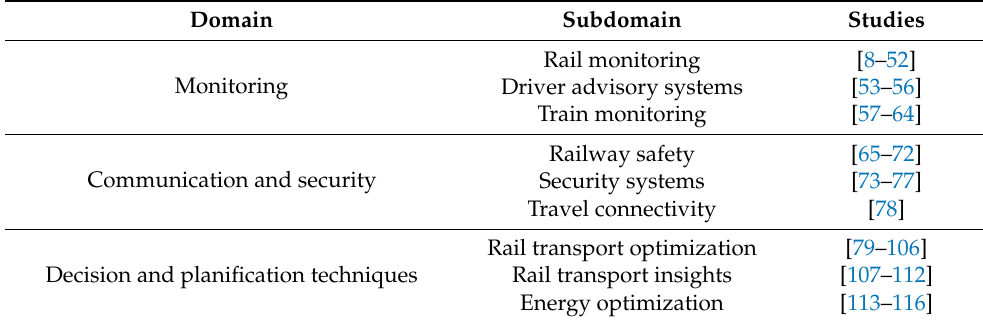
Figure 4. Distribution of the selected papers by application domain. Table 4. Clustering of the selected studies by